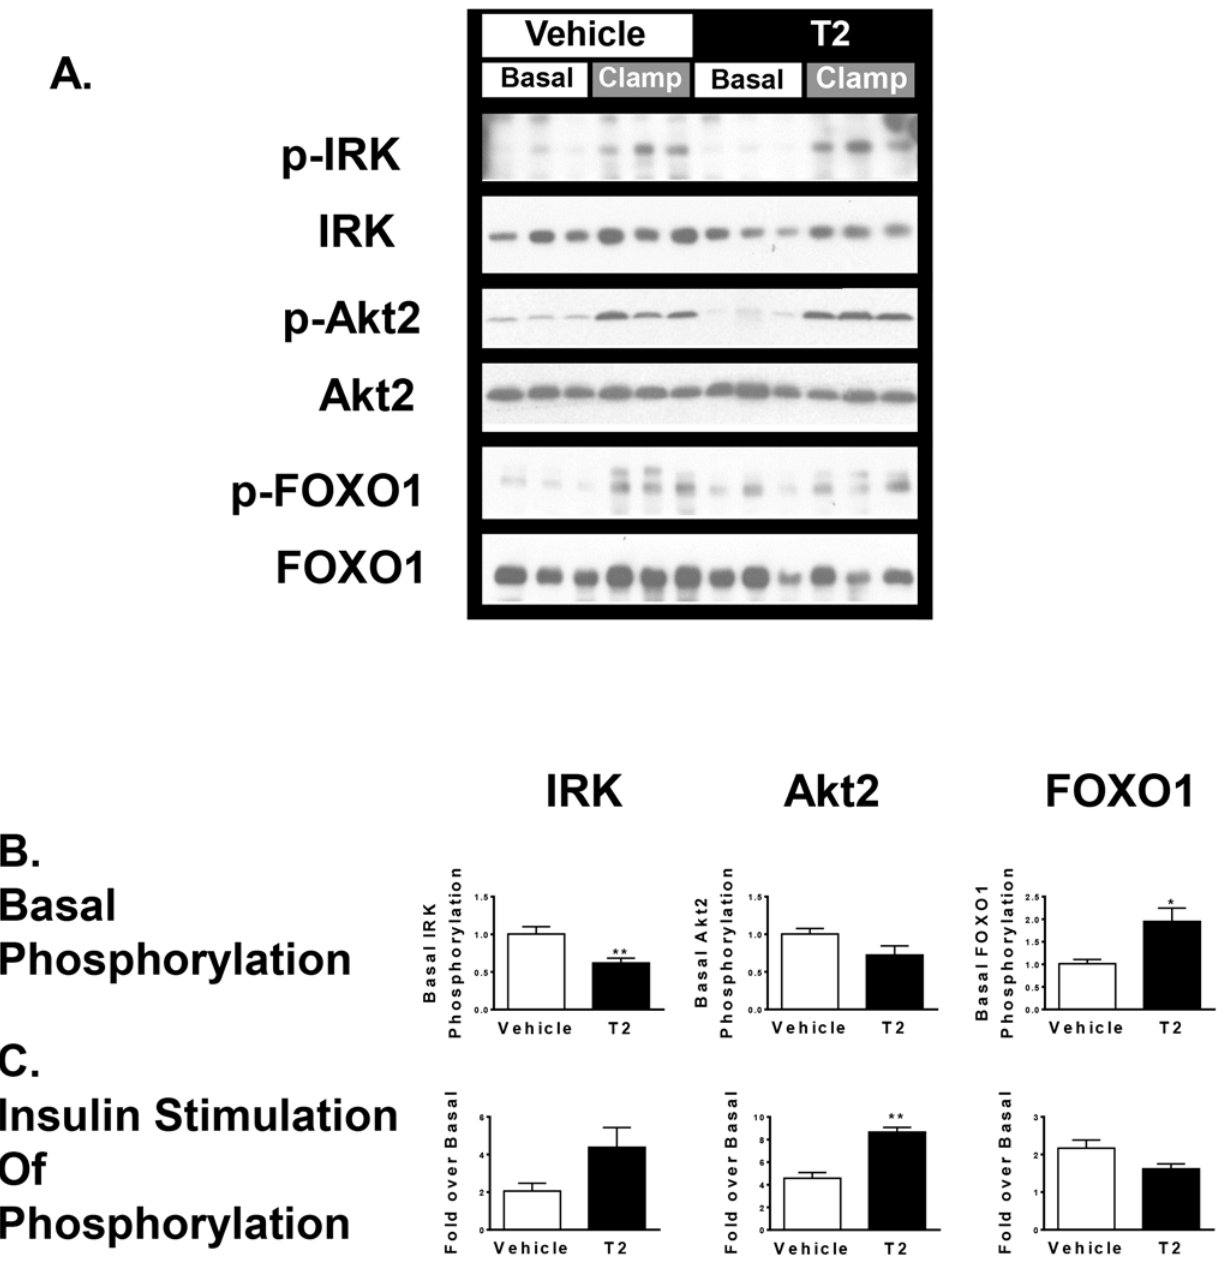
Fig 2. Hepatic insulin signaling through insulin receptor kinase phosphorylation, Akt2 phosphorylation, and FOXO1 phosphorylaiton, assessed by Western blot. A. Representative immunoblots. B. Fasting (unstimulated) phosphoprotein abundance normalized to total protein abundance. C. Protein phosphorylation in the insulin stimulated state relative to the basal (fasting) state. ( * P < 0.05; ** p < 0.01 T2 treatment vs. vehicle treatment; n = 4 – 6 per group).